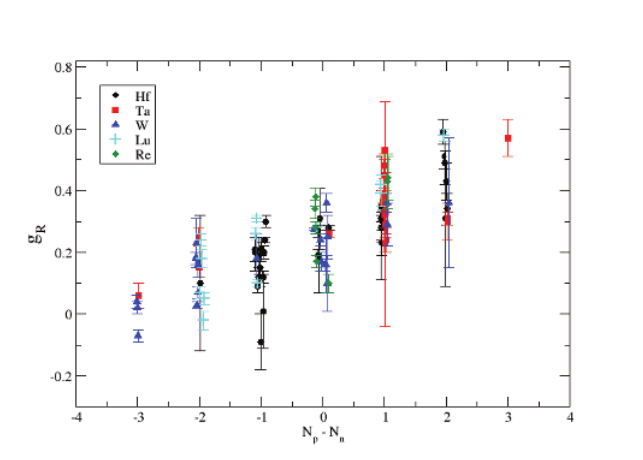
Figure 1 Values of g plotted as a function of N